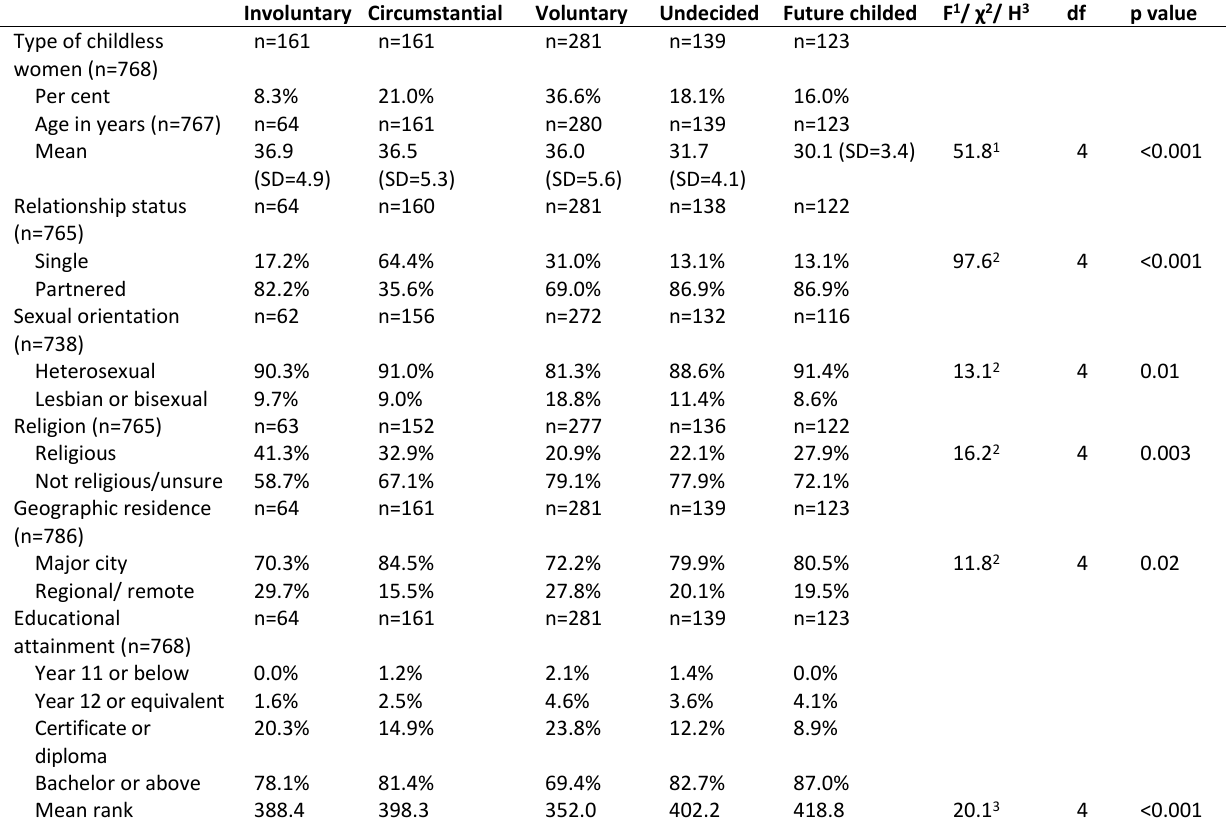
Table 2. Demographic characteristics of types of childless women.